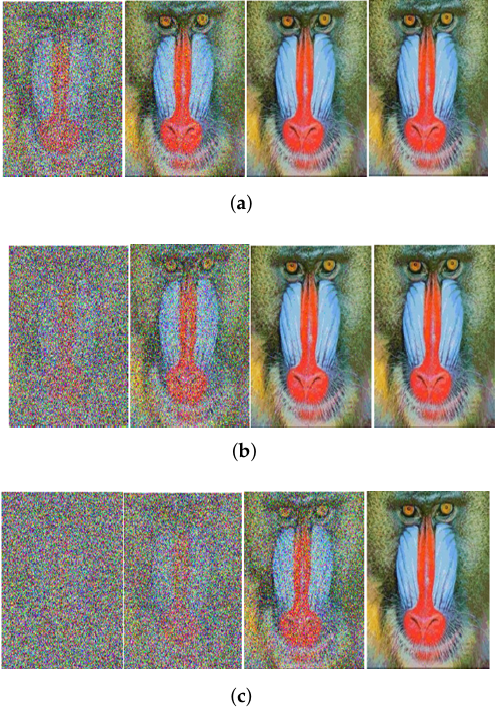
Figure 4. Received Image with Massive MIMO incorporated FFT-OFDM over a Rayleigh channel, Modulated with BPSK and at SNR = 0, 10, 20, 30 dB from Left to Right for different number of users,